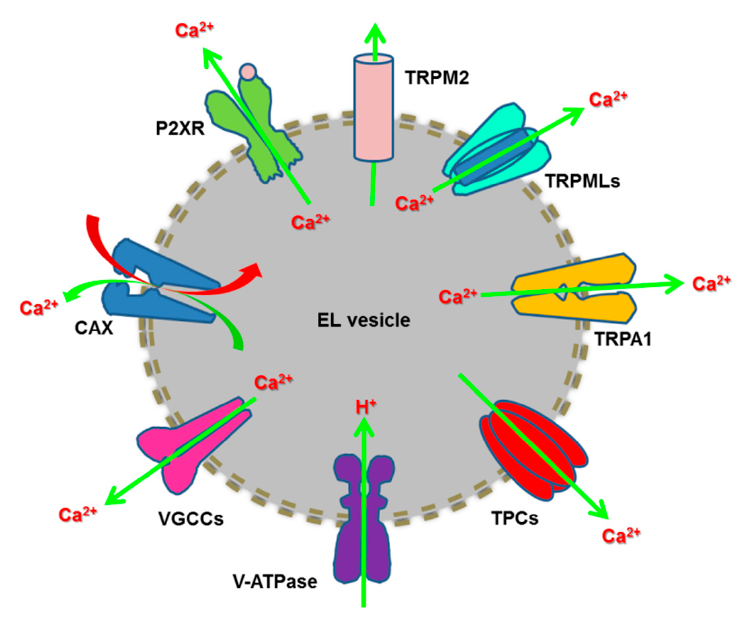
Figure 1. The endolysosomal Ca 2+ toolkit. Refilling of the EL Ca 2+ store is driven by the H+ gradient established through the v-ATPase and effected by a Ca 2+ /H + exchanger (CAX) in nonplacental mammalian cells. EL Ca 2+ release may occur through multiple Ca 2+ -permeable channels, such as such as TRPML1-3, TRPM2, TRP Ankyrin 1 (TRPA1), TPC1-2, ATP-gated ionotropic P2X4 receptors and voltage-gated Ca 2+ channels (VGCCs).